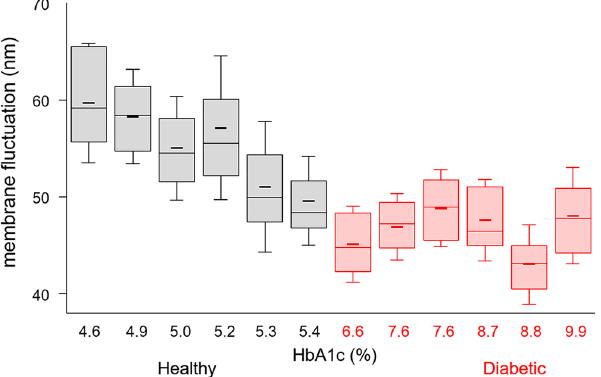
Figure 4. Box plots of membrane fluctuations for measured RBCs from six healthy controls and six diabetic patients in increasing order of HbA1c. Boxes show median values with upper and lower quartiles. Short horizontal lines and error bars in each box plot denote the mean values and standard deviations of individual cell measurements (n = approx. 40 per each group),